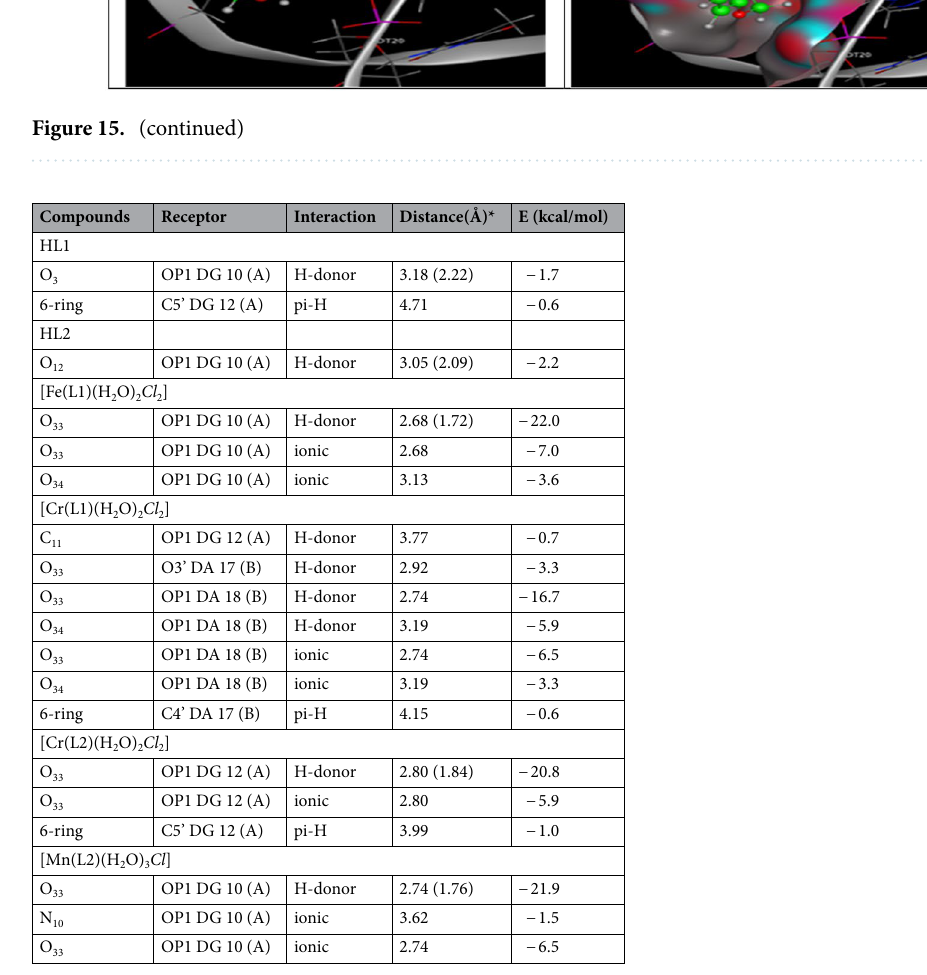
Table 11. The docking interaction data computations of HL1, HL2, [Fe(L1)(H 2 O) 2 Cl 2 ], [Cr(L1)(H 2 O) 2 Cl 2 ],